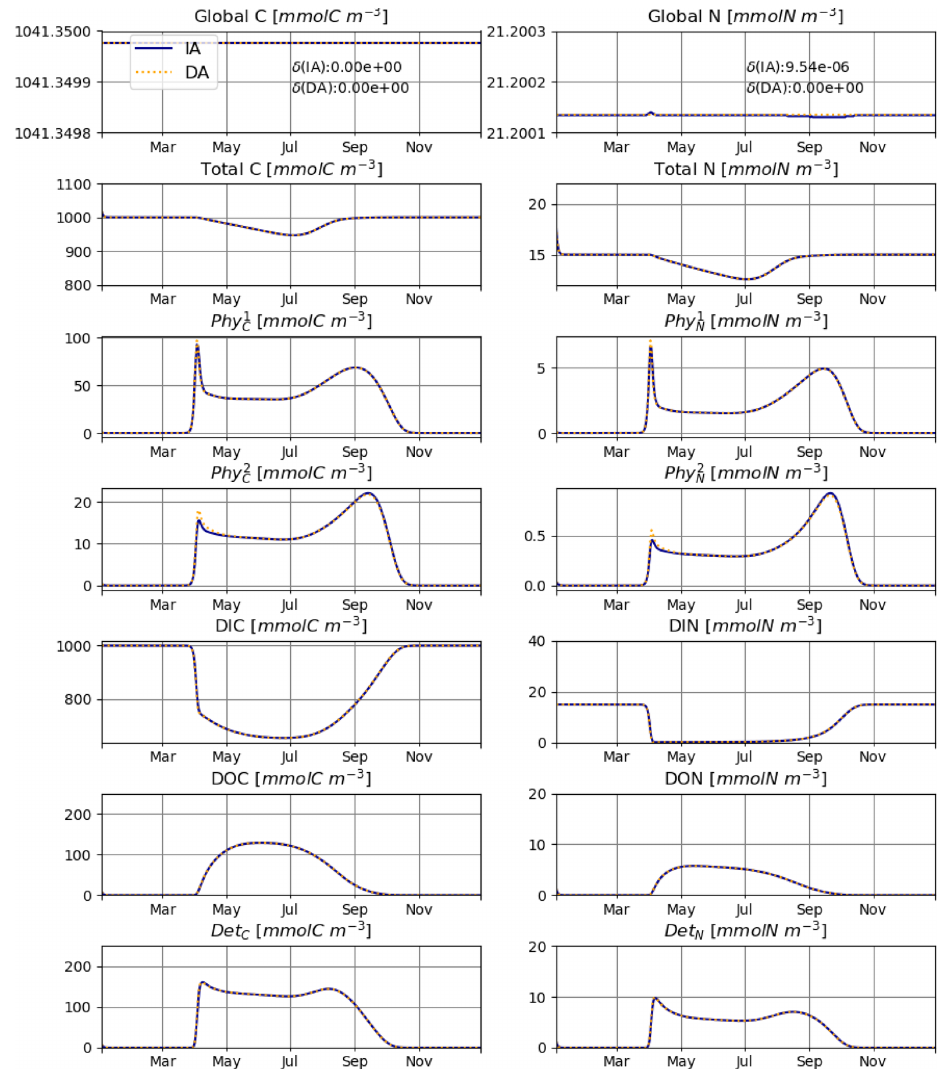
+ DIC + DOC + Det C C